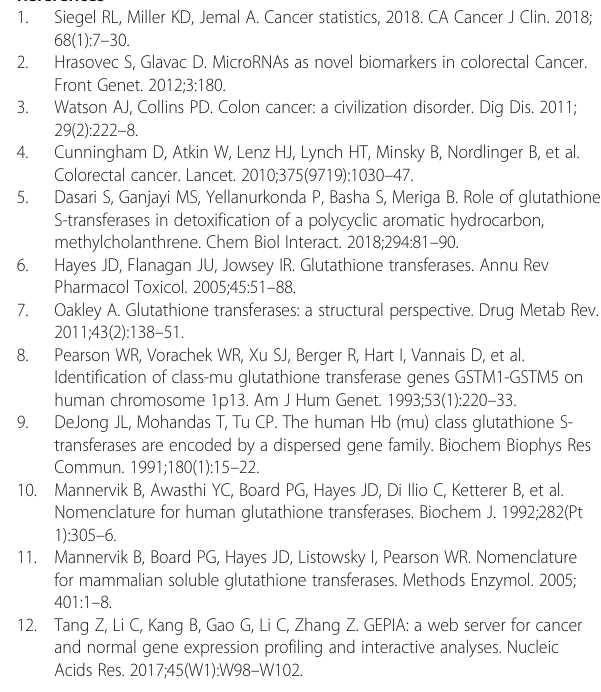
Additional file 1: Figure S1. GO functional enrichment analysis by BiNGO of GSTM family. Additional file 2: Figure S2. Gene interaction network for the GSTM1 gene and potentially related COAD gene cohort in TCGA. Additional file 3: Figure S3. Gene interaction network for the GSTM2 gene and potentially related COAD gene cohort in TCGA. Additional file 4: Table S1. Clinical information. Additional file 5: Table S2. KEGG enrichment result by GSEA for GSTM2 (c2.all.v6.2.symbols.gmt). Additional file 6: Table S3. GO enrichment results by GSEA for GSTM2